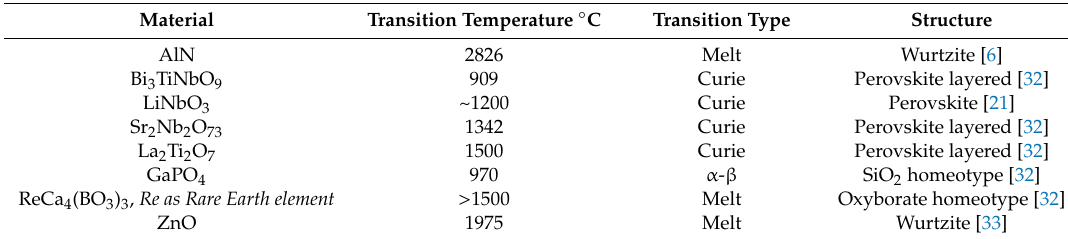
Table 3. Piezoelectric materials